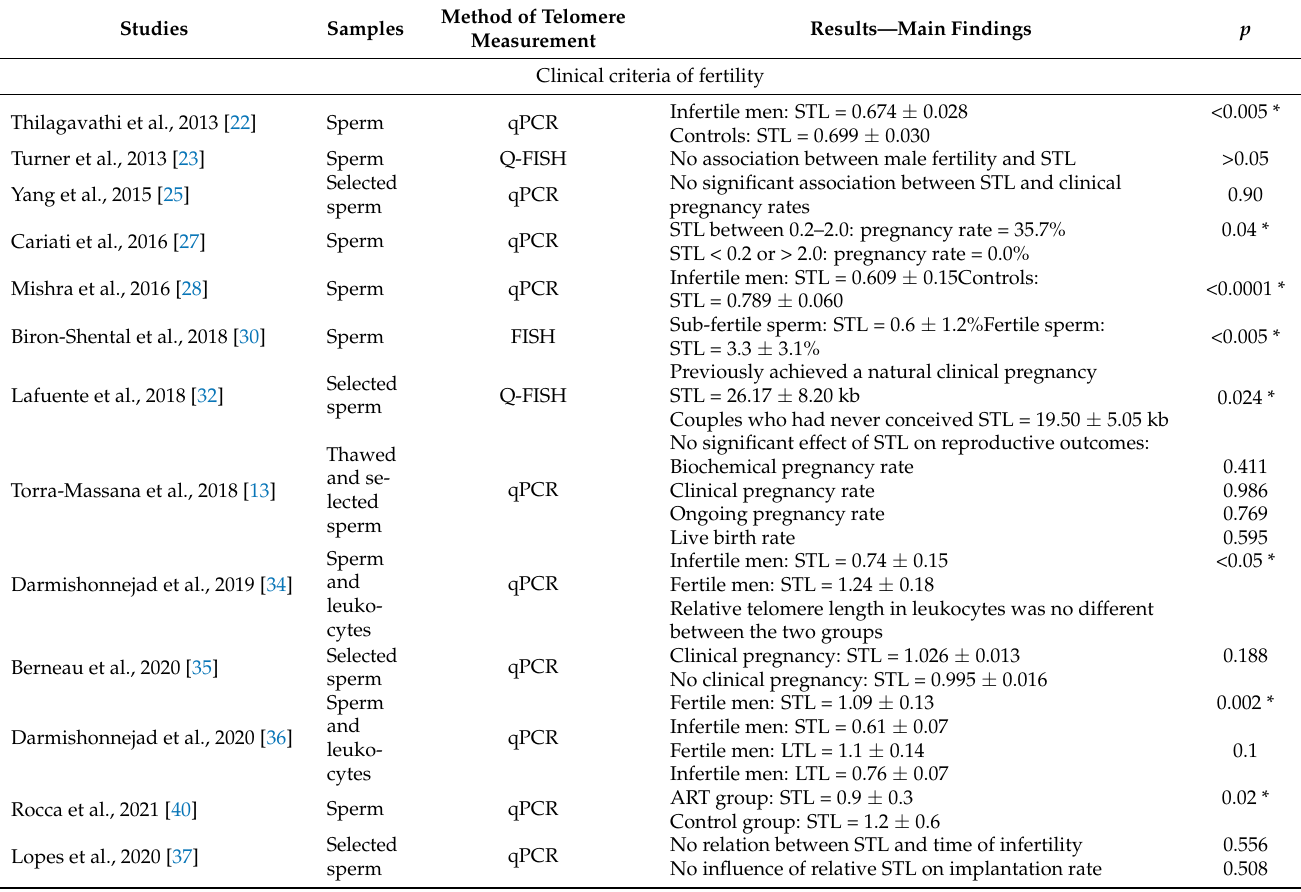
Table 3. Results for telomere length and